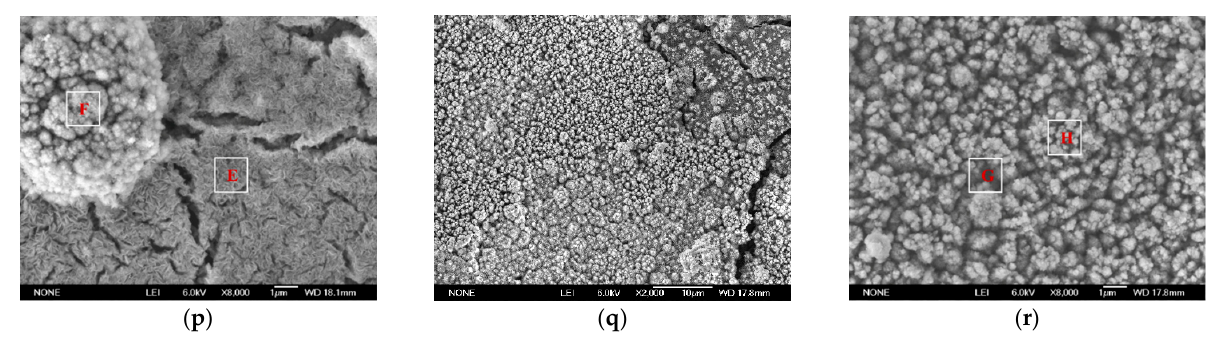
Figure 4. The morphology of the corrosion products at the black-gray area under different corrosion time conditions: ( a ) and ( b ) 10 min, ( c ) and ( d ) 20 min, ( e ) and ( f ) 40 min, ( g ) and ( h ) 80 min, ( i ) and ( j ) 2 h, ( k ) and ( l ) 3 h, ( m ) and ( n ) 4 h, ( o ) and ( p ) 5 h, ( q ) and ( r ) 7 h. ( 1, 2, 3, 4, 5, 6, 7, 8, 9 and 10 are the EDS scanning points. A, B, C and D are